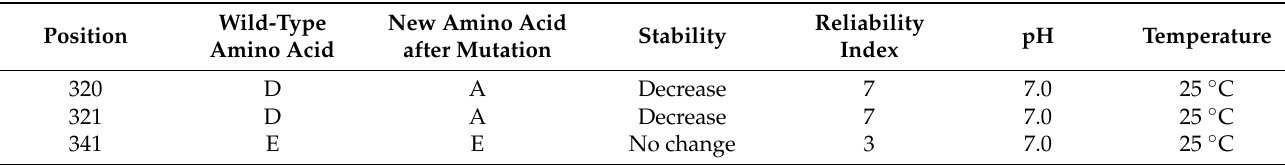
Table 10. Protein stability reports generated by I-Mutant.